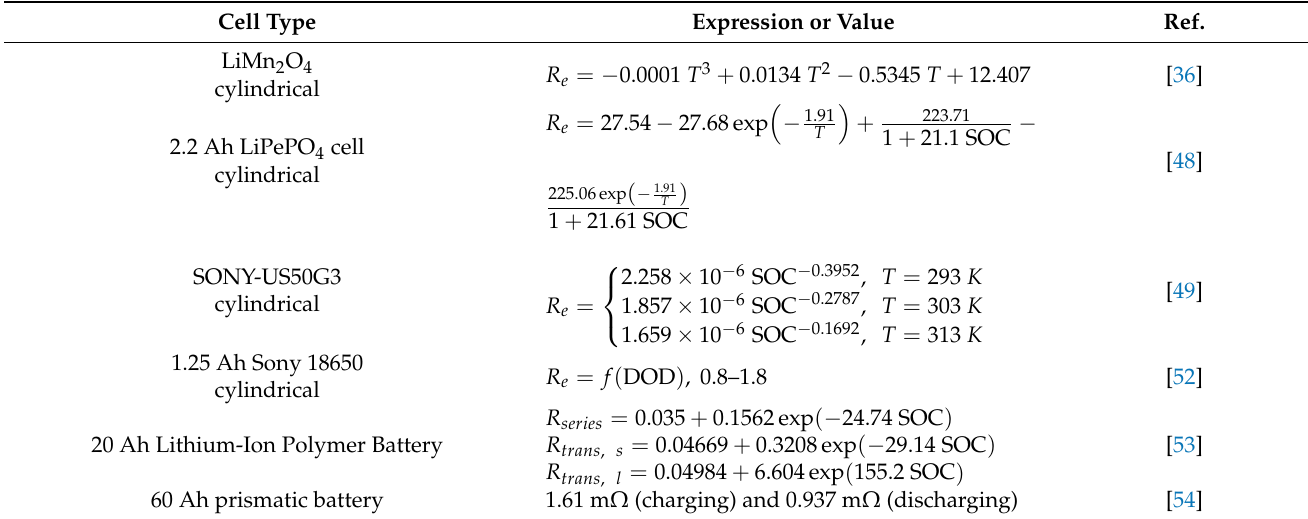
Table 2 comprises some literature expressions of internal electrical resistance. Table 2. Expressions of internal electrical resistance in the